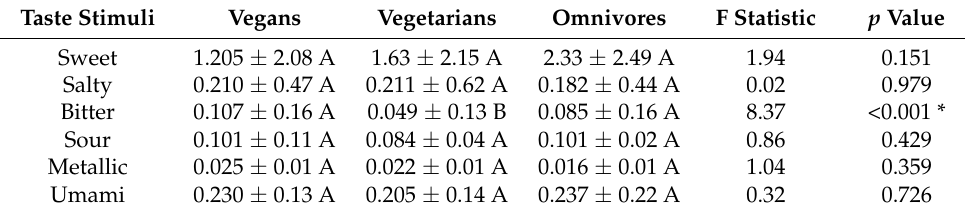
Table 2. Detection thresholds (means and standard deviation in g · L − 1 ) of participants in three diet groups for the six taste stimuli used. Within a row, means with different letters are statistically different at p < 0.05. Significant main effects ( p < 0.05) from the diet groups are indicated by asterisks. Taste Stimuli Vegans Vegetarians Omnivores F Statistic p Value Sweet 1.205 ± 2.08 A 1.63 ± 2.15 A 2.33 ± 2.49 A 1.94 0.151 Salty 0.210 ± 0.47 A 0.211 ± 0.62 A 0.182 ± 0.44 A Bitter 0.107 ± 0.16 A 0.101 ± 0.11 A 0.025 ± 0.01 A 0.230 ± 0.13 A